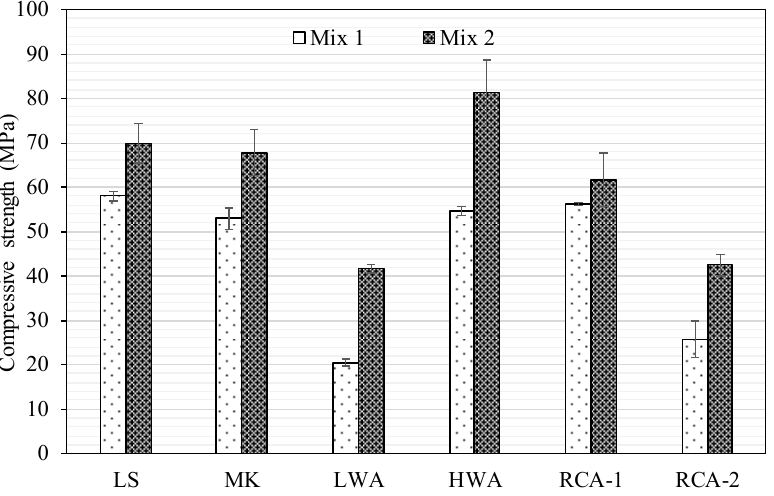
Figure 2. Compressive strength results for Mix 1 and Mix 2.